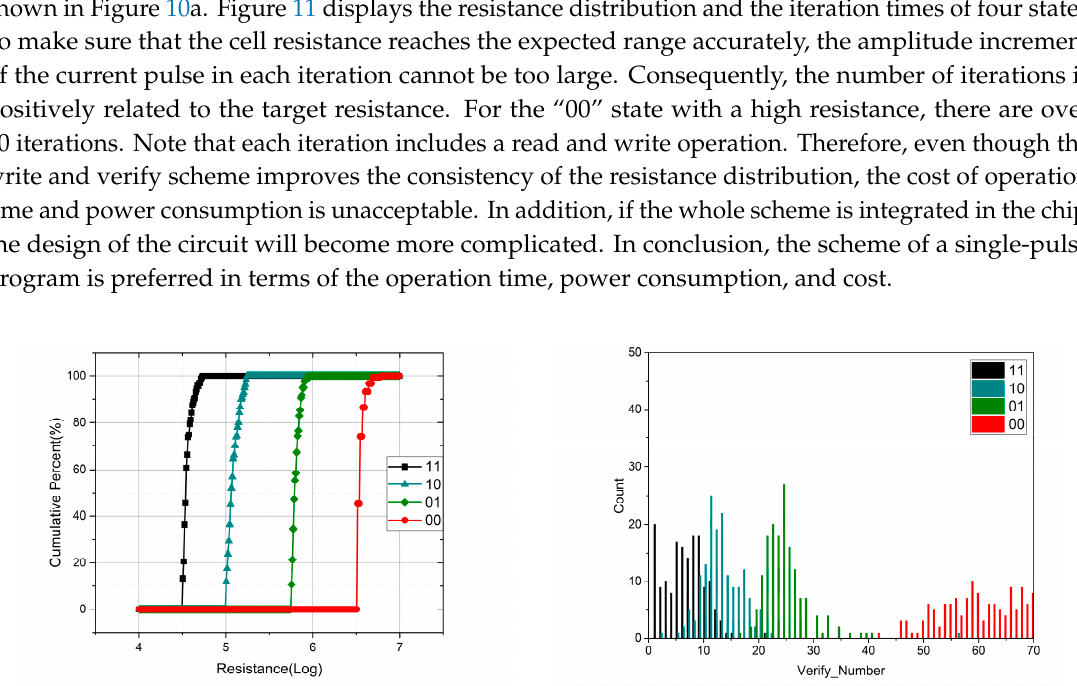
Figure 12. Measurements showing the multilevel drift behavior for a 1000 s time frame. 4.3. Simulation Results Figure 13a shows the simulation graphs of the ramp-down current pulse generator circuit, and the shape of each pulse corresponds to the design scheme in Figure 7. Figure 13b,c show the readout simulation results of four states in the PCM cell during the two read operations. Taking the worst case into consideration, the final readout time is 65 ns.